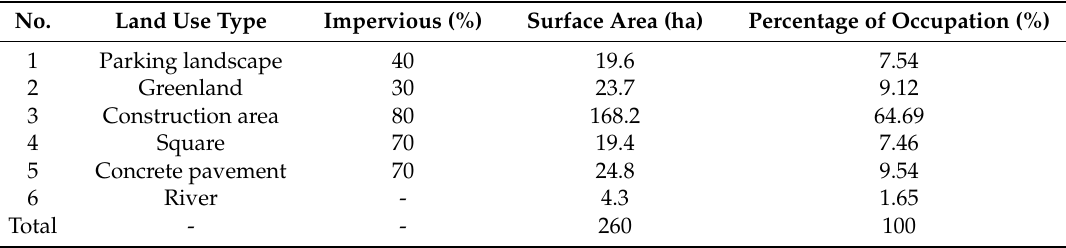
Table 4. Area of different land use